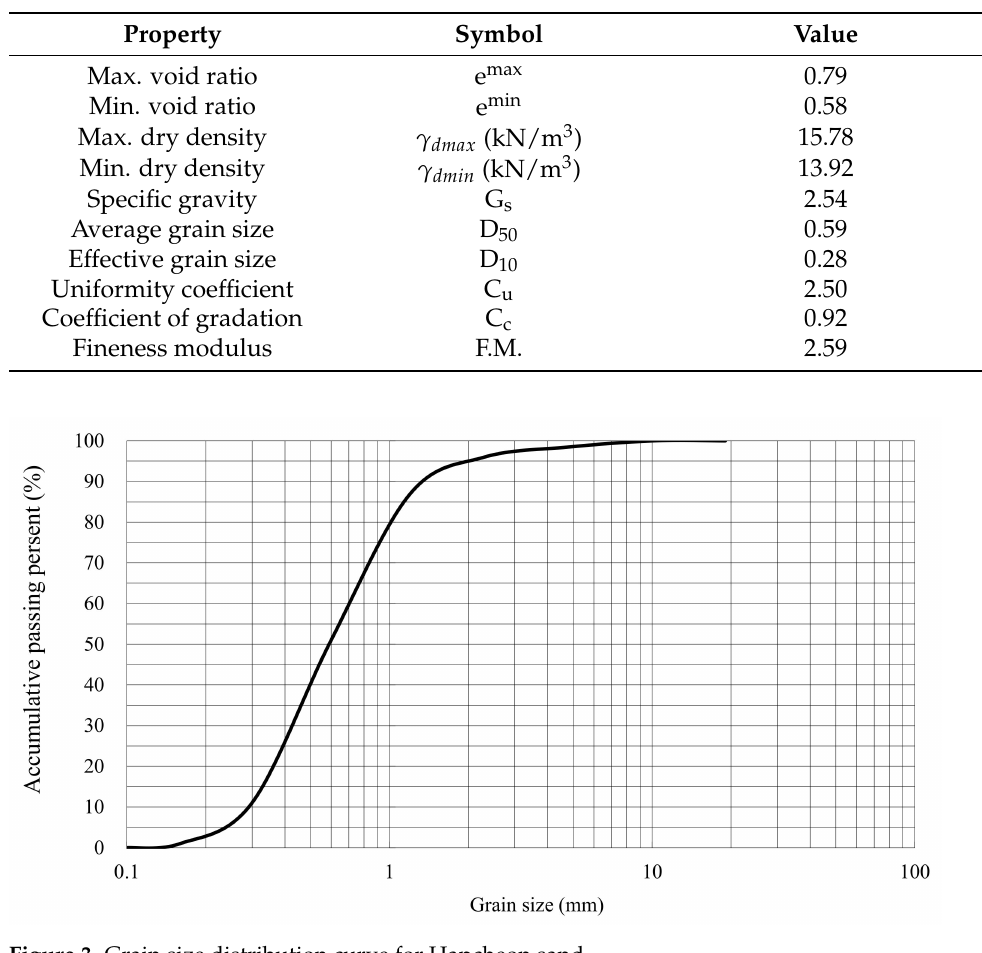
Table 3. Physical properties of Hapcheon sand for model test.